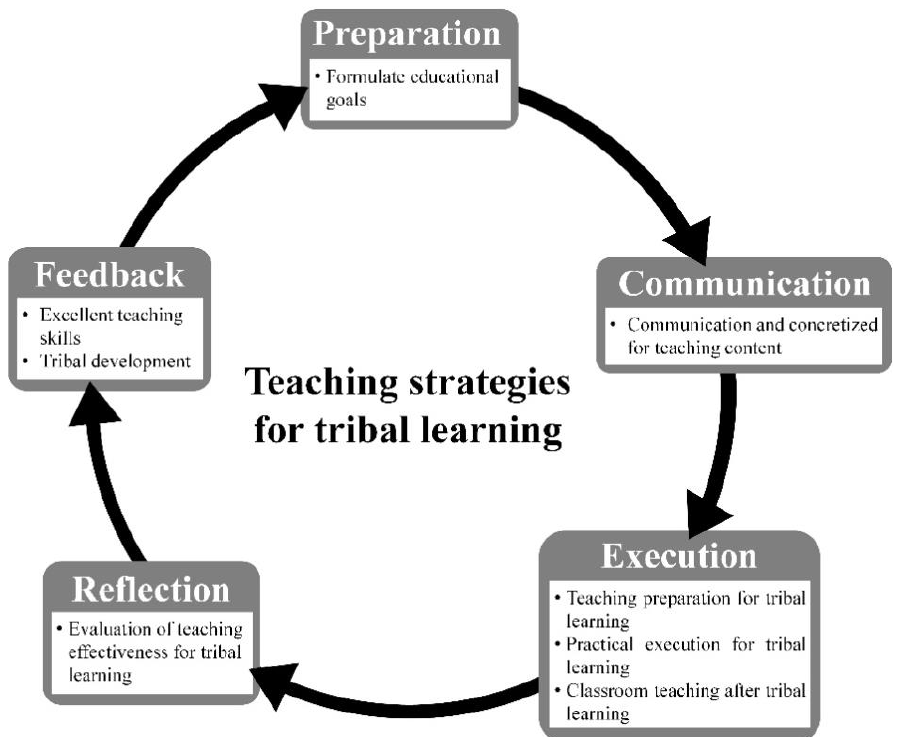
Figure 1: The Five-Stage Tribal Learning